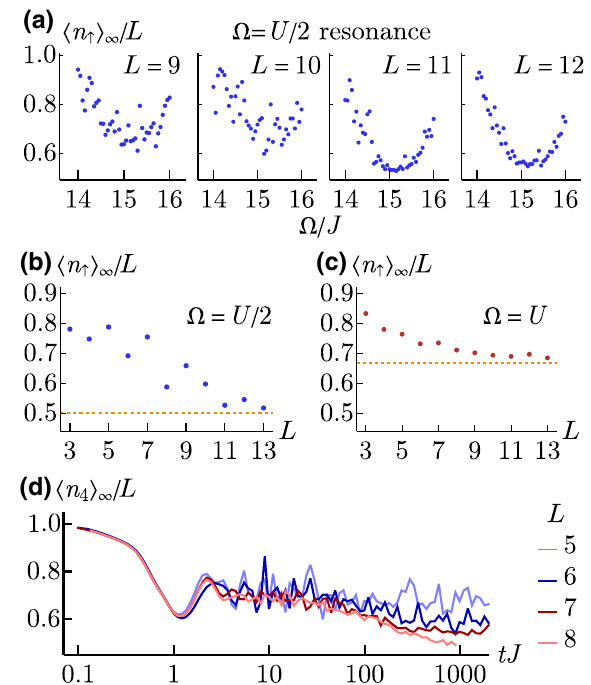
FIG. 13. (a) Long-time average population (cid:12)ˆ n ↑ (cid:4) ∞ for the n = 2 system near the (cid:2) = U / 2 resonance, for different system sizes L . The parameters are U / J = 30, φ = π/ 2, time evolu- tion is done to tJ = 1500, and averaging is done over the second half of the evolution, tJ = 750 to 1500. (b) Long-time average population at the (cid:2) = U / 2 resonance in terms of system size, fixing (cid:2)/ J = 15.15 (where the peak appears to be centered). The orange dashed line is the thermal prediction of 1 / 2. (c) Same as (b) but for the (cid:2) = U resonance, fixing (cid:2)/ J = 30.15. (d) Long-time average population for the n = 4 system at the (cid:2) = U / 2 resonance for different system sizes L . The parameters are U / J = 30, φ =